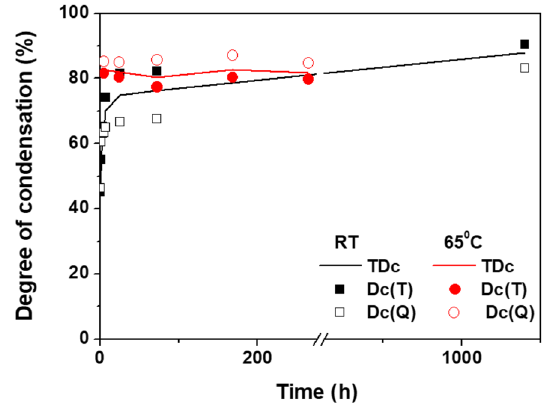
Figure 6. Evolution of the total condensation degree (TDc), condensation degree of T species (Dc(T)) and Q species (Dc(Q) for polysiloxane hybrids synthesized from the [TMOS]/[MPTS] mixture at room temperature (RT) and at 65 °C for different times.